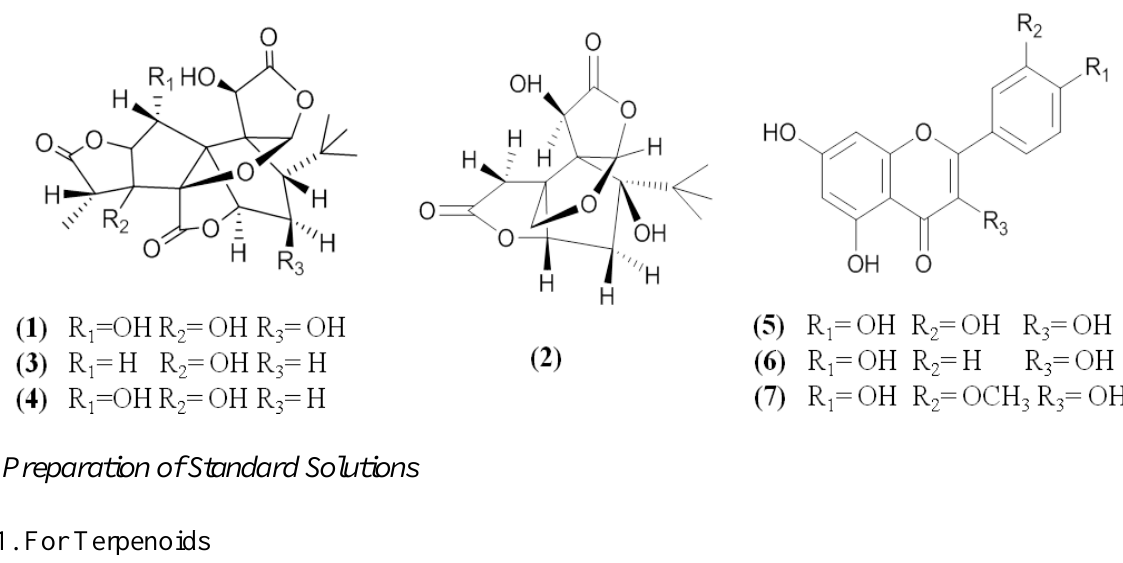
Figure 1. Chemical structures of the terpene lactones and flavonol aglycones in the G. biloba leaves as chemical